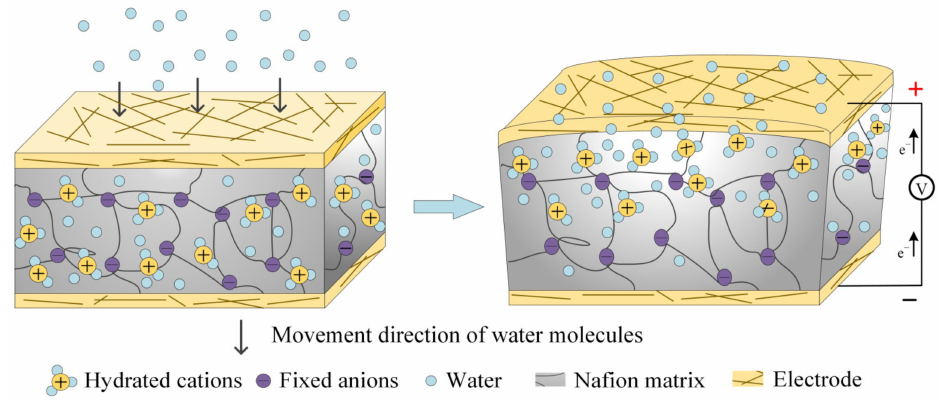
Figure 1. Humidity sensing mechanism of